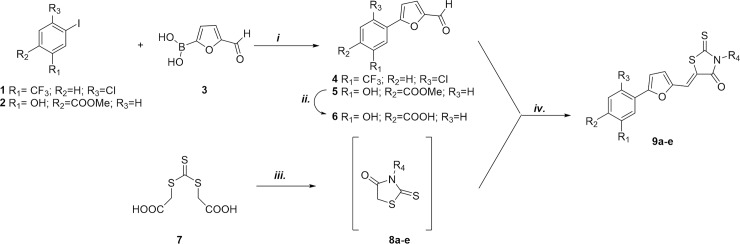
Synthesis of substituted rhodanine derivatives 9 a–e: i. Pd(PPh3)2Cl2, Na2CO3, DMF/EtOH, RT, 1h; ii. 1N NaOH (aq), MeOH/THF, reflux; iii. DME, Et3N, MW (300 W), 90°C, 10 min. iv. aldehyde 4 or 6, DME, MW (300 W), 110°C, 5 min.